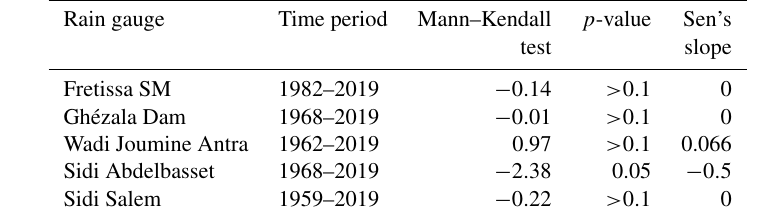
Table 1. Mann–Kendall test and Sen’s slope for the maximum yearly dry spell length for Ichkeul lake basin. Rain gauge